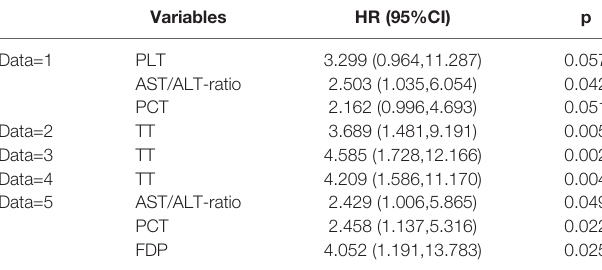
TABLE 10 | Multivariate cox regression analysis in fi ve complete data obtained by MI. Variables